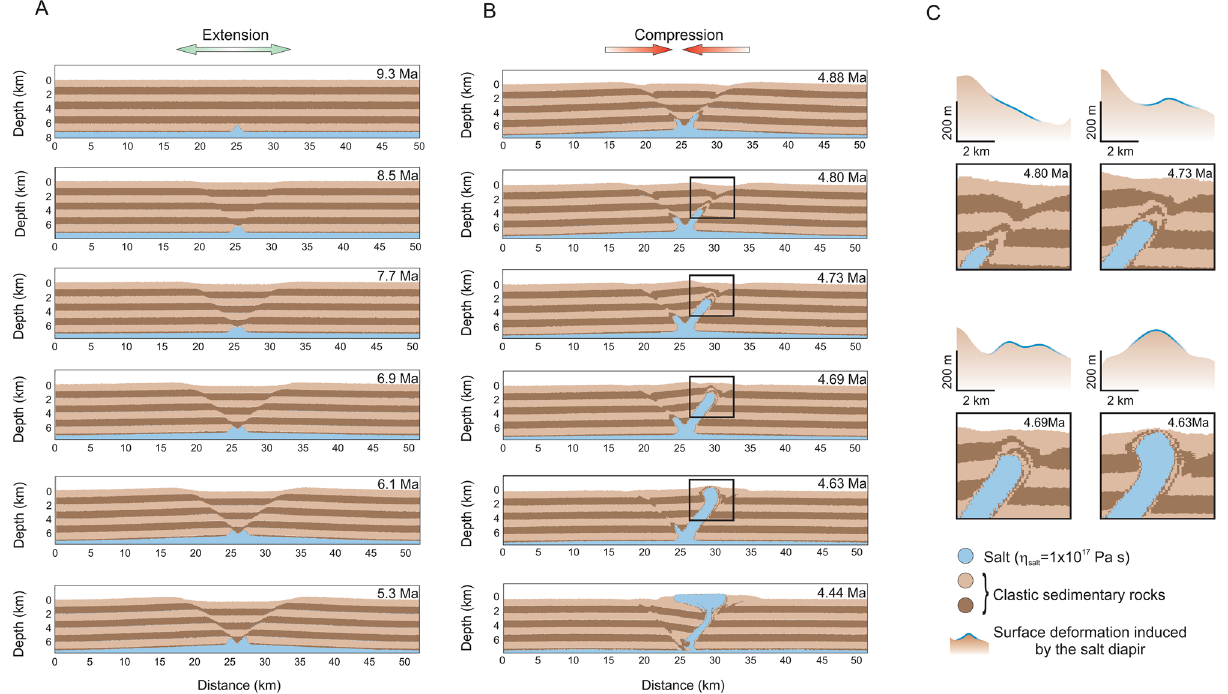
Figure 3. Modeling results of a salt diapir (blue color) piercing through an initial 7.2 km thick sedimentary layer (represented in two brown color tones for better visualization of deformation). In this numerical experiment the initial salt layer thickness is 800 m and salt diapir viscosity of 1 × 10 17 Pa s. In all